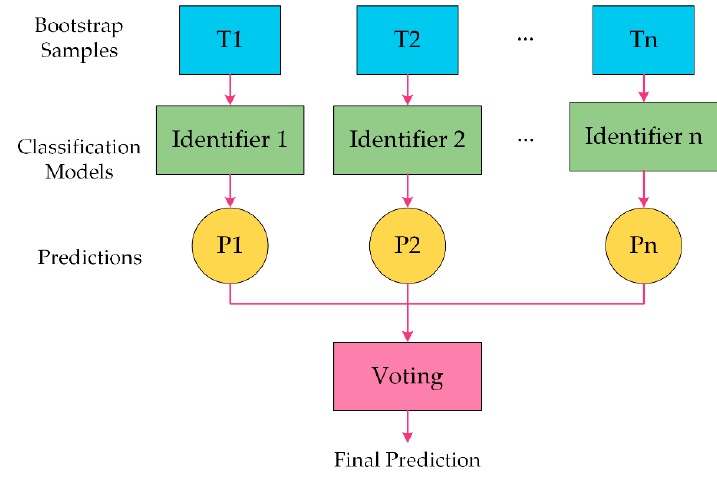
Figure 3. Block diagrams of the bagging algorithm.